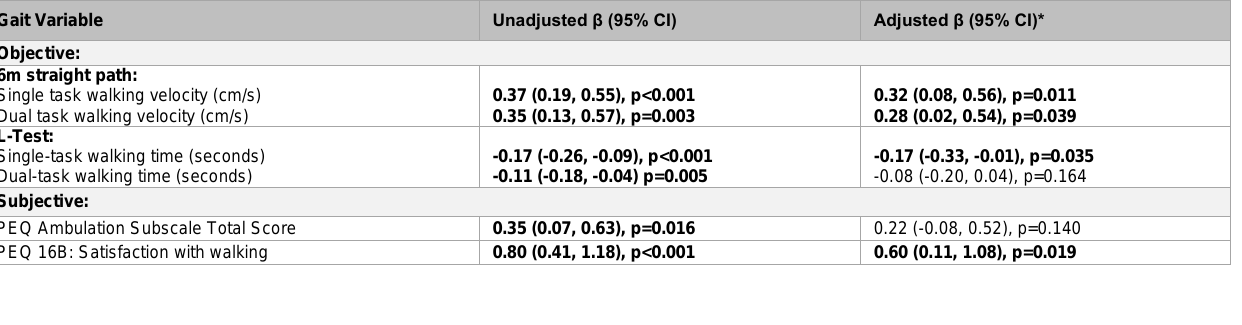
Table 3: Results of multivariable linear regression for the association of objective (6m straight path and L-test walking tests) and subjective (PEQ) measures of walking ability on self efficacy (Activities-specific Balance Confidence Scale). Abbreviations: β, regression coefficient; CI, confidence interval; PEQ, Prosthesis Evaluation Questionnaire. *Adjusted for age, level of amputation, number of comorbidities, number of